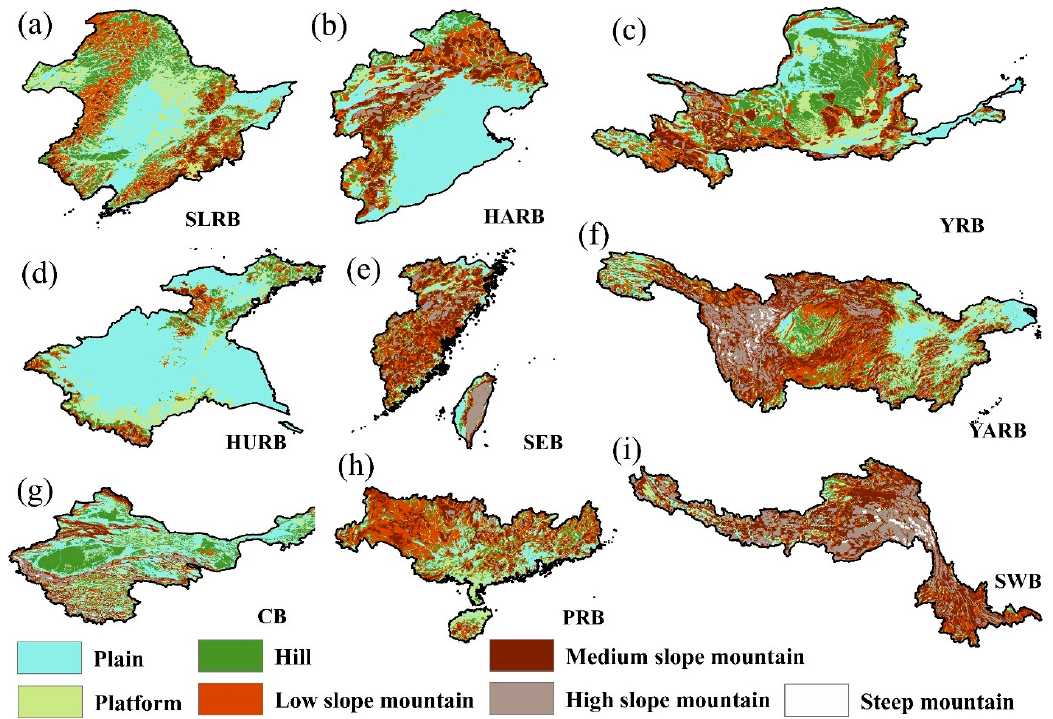
Figure 10. Map of the landforms in the SLRB ( a ), HARB ( b ), YRB ( c ), HURB ( d ), SEB ( e ), YARB ( f ), CB ( g ), PRB ( h ), and SWB ( i ) river basins. The topography data were provided by the Recourse and Environment Data Cloud Platform http://www.resdc.cn/ (accessed on in 23 May 2022).